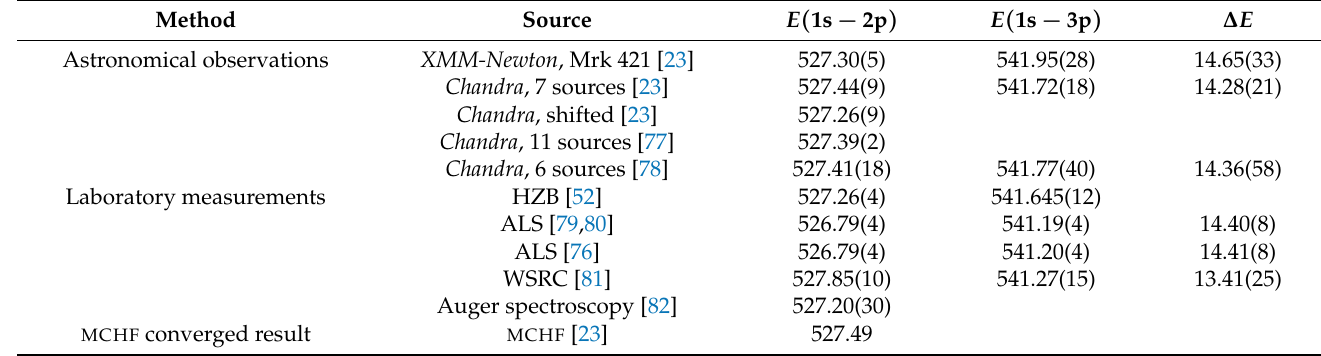
Table 1. Comparison of astronomically observed, laboratory measured, and computed O I K α and K β line energies (eV).